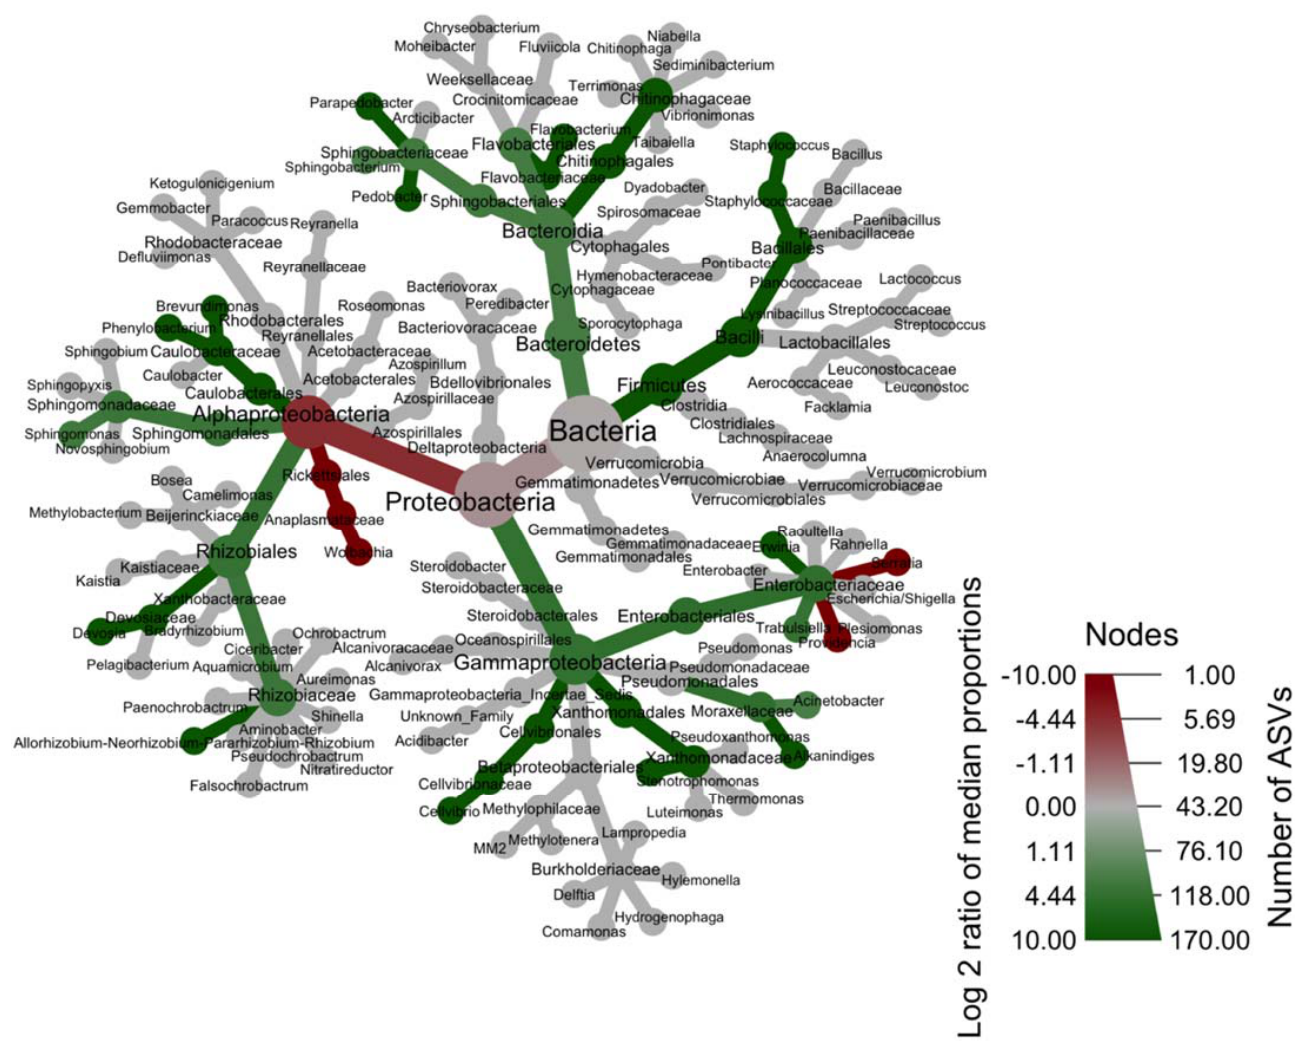
Figure 4. Heat trees comparing taxa relative abundances between Wolbachia -free and infected lines. The color of each taxon represents the log-2 ratio of median relative abundances observed for each treatment. Only significant differences are colored. Taxa colored in green are enriched in Wolbachia -free flies while taxa colored in red are enriched when Wolbachia are present.